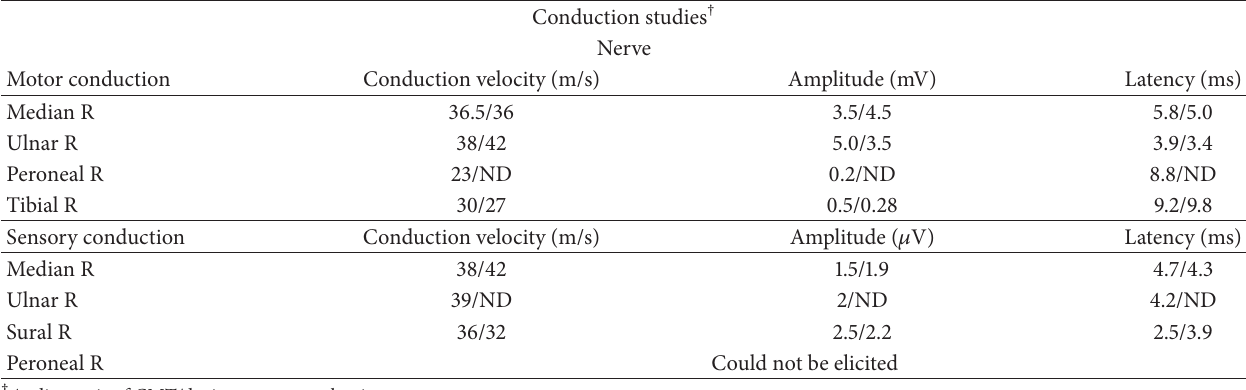
Table 1: Comparative motor and sensory conduction studies of the patient at diagnosis of CMT and during present evaluation.